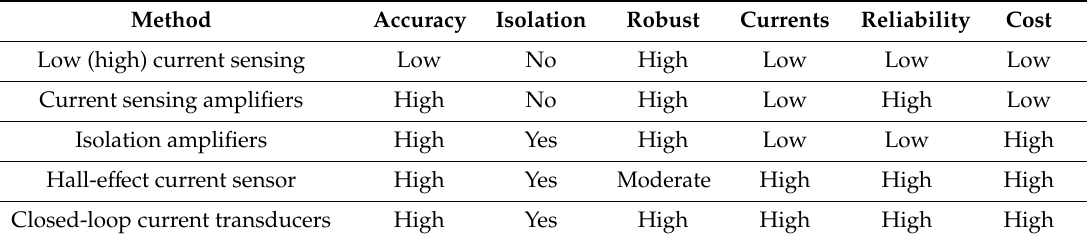
Table 1. Summary of current measurement methods.